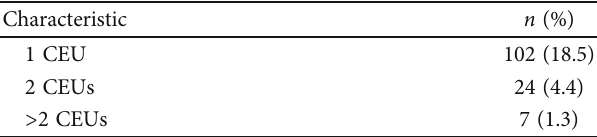
Table 1: Demographic and practice characteristics of